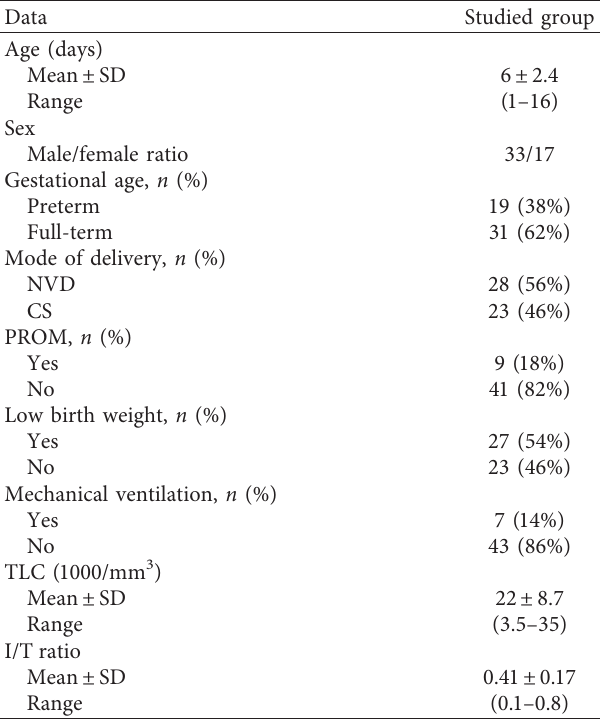
Table 2: Demographic and laboratory data of the studied group. Data Studied